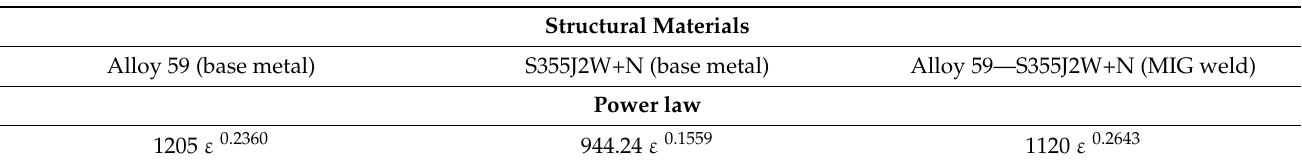
Figure 17. True stress–true strain curves of the Alloy 59, S355J2W+N steel and their MIG joint: ( a ) full characteristics, ( b ) the initial sections of the tensile curves from ( a ). Table 4. Power law equations for the Alloy 59, S355J2W+N steel and their MIG joining for the true stress–true strain curves shown in Figure 18.